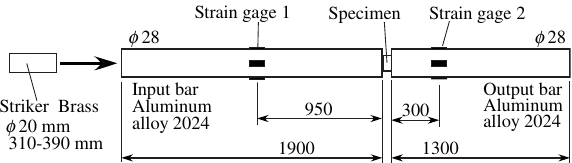
Fig. 2. Experimental setup for split Hopkinson pressure bar method. Table 1. Material constants of input and output bars used in calculation.